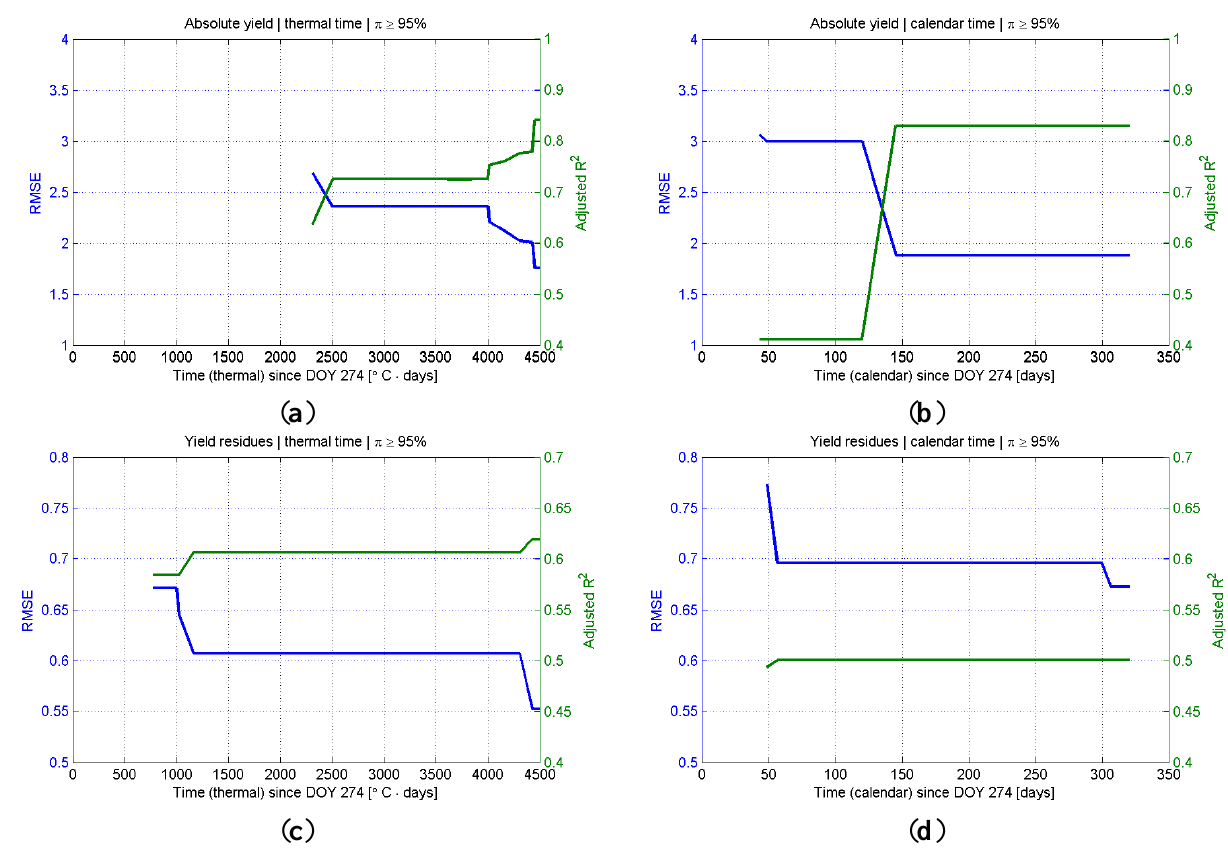
Figure 12. Performances of best available metric(s) at a given time in the season when using either thermal ( a , c ) or calendar time ( b , d ). The best metric(s) are selected independently based on either indicator, RMSE and R 2 . Only metric(s) that are significantly adj